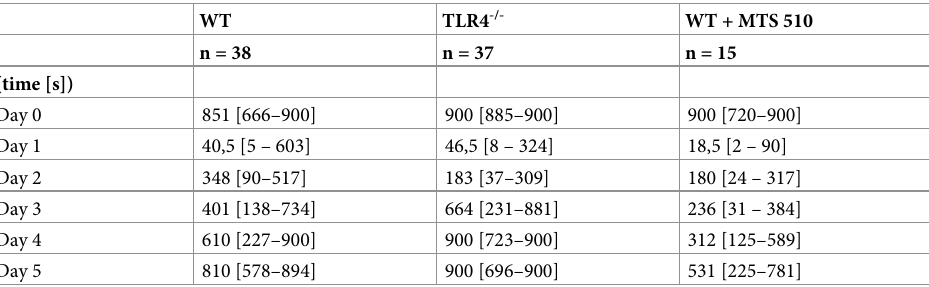
Table 3. Rota rod